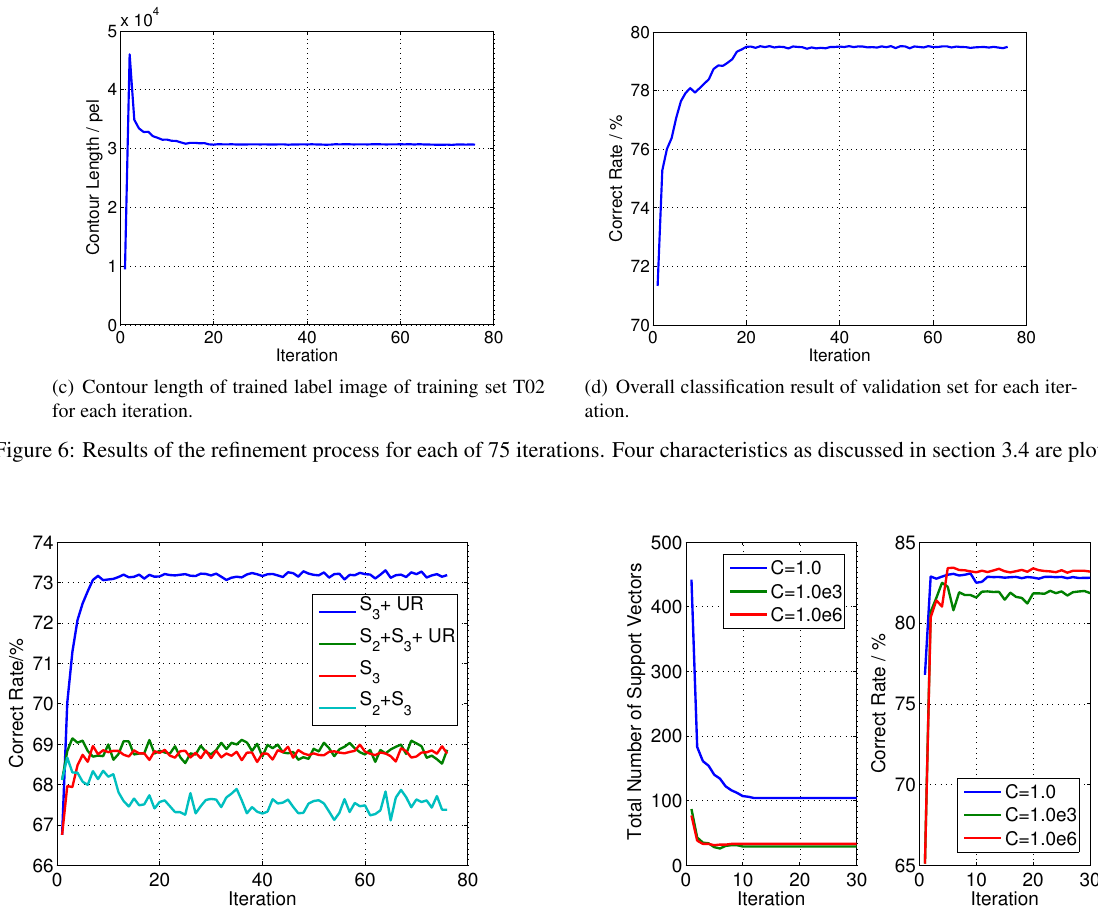
Figure 8: Comparison for different values for cost variable C when classifying with an SVM using slack